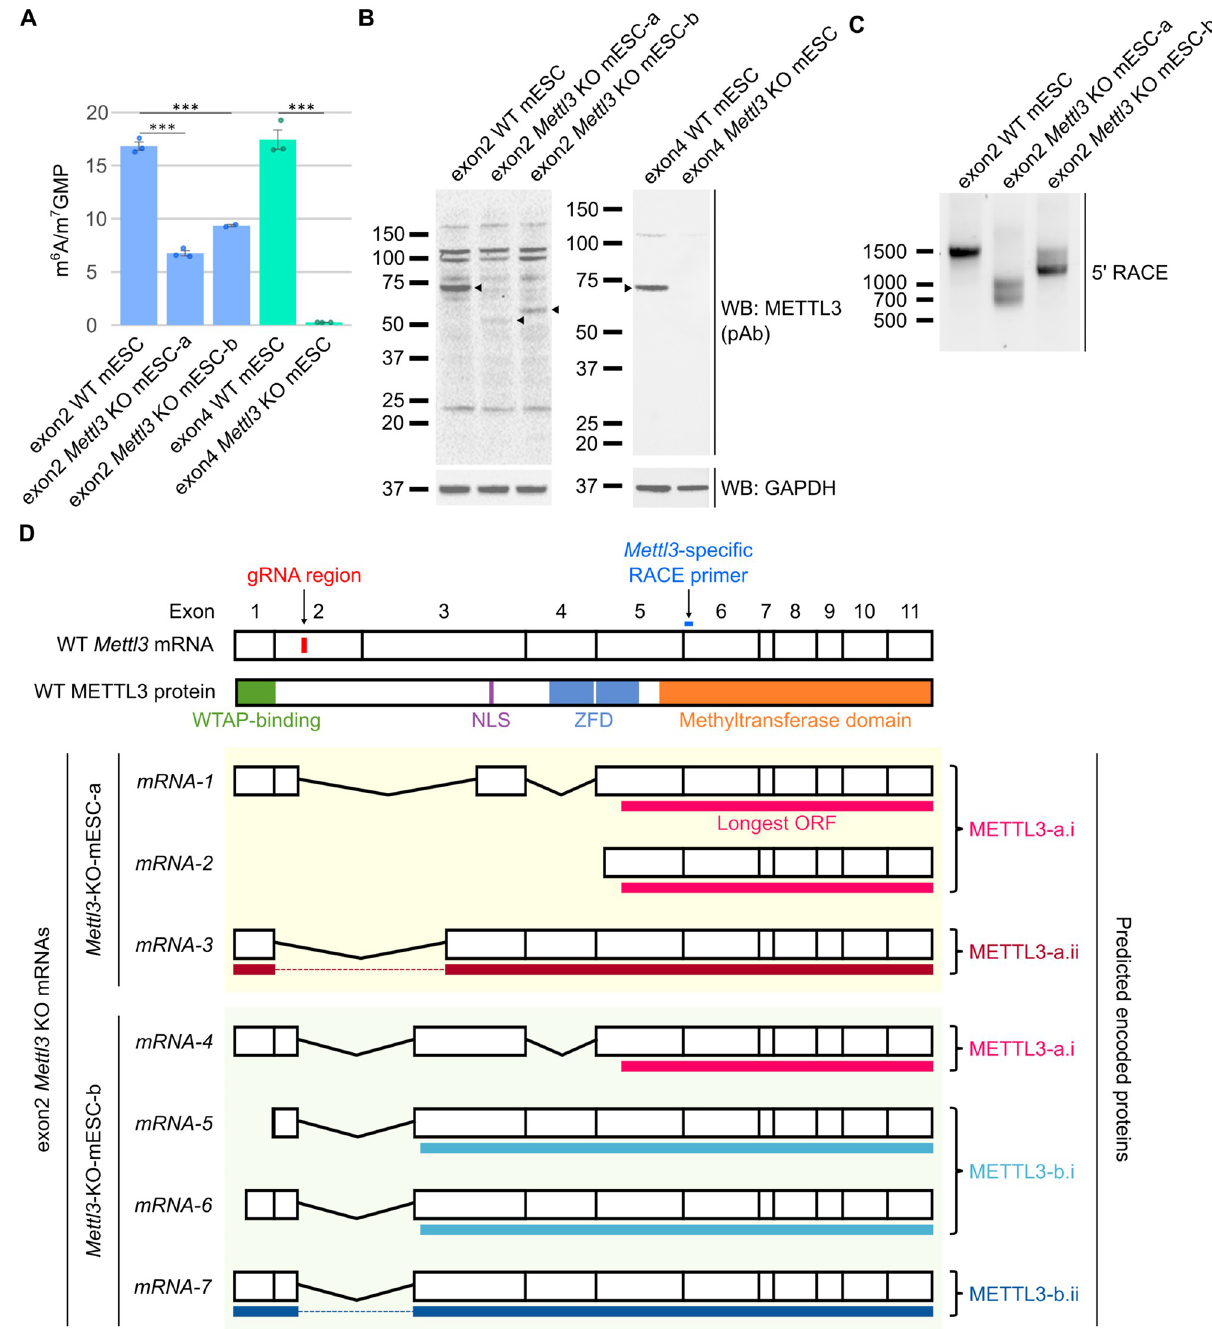
Fig 1. Previously described Mettl3 KO mESC lines express shorter isoforms of Mettl3 . ( A ) Mettl3 KO mESCs from two groups have different m 6 A levels. To reconfirm the m 6 A levels using quantitative methods, we performed mass spectrometry to estimate the m 6 A in mRNA. Exon2 Mettl3 KO mESCs show persistence of 40.2% (exon2 Mettl3 KO mESC-a) and 55.6% (exon2 Mettl3 KO mESC-b) m 6 A, respectively, while exon4 Mettl3 KO mESCs show 1.45% m 6 A compared to WT. This confirms that exon4 Mettl3 KO mESCs have near-complete loss of m 6 A, but not the exon2 Mettl3 KO mESCs. Error bars indicate standard error ( n = 3 for all, except n = 2 for exon2 Mettl3 KO mESC-b). � = p -value < 0.5, �� = p -value < 0.01, ��� = p - value < 0.005, n.s. = not significant. Underlying data can be found in S1 Data. ( B ) Exon2 Mettl3 KO mESCs exhibit new anti- METTL3-immunoreactive bands. To investigate the effectiveness of the Mettl3 knockout, we measured the loss of METTL3 via WB. Full-length METTL3 (75 kDa, arrowhead) was lost in both KO cell lines, but new bands, which were reactive to the anti-METTL3-antibody, appeared at approximately 50 kDa in exon2 Mettl3 KO mESC-a and approximately 55 kDa in exon2 Mettl3 KO mESC-b (arrowheads). This indicates the possibility that a novel smaller METTL3 protein was expressed in the exon2 Mettl3 KO mESCs. In contrast, exon4 Mettl3 KO mESCs have no proteins reactive to anti-METTL3-antibodies. 30 μ g per lane. ( C ) 5 0 RACE reveals the expression of shorter Mettl3 mRNAs in the Mettl3 KO mESCs. We used 5 0 RACE to